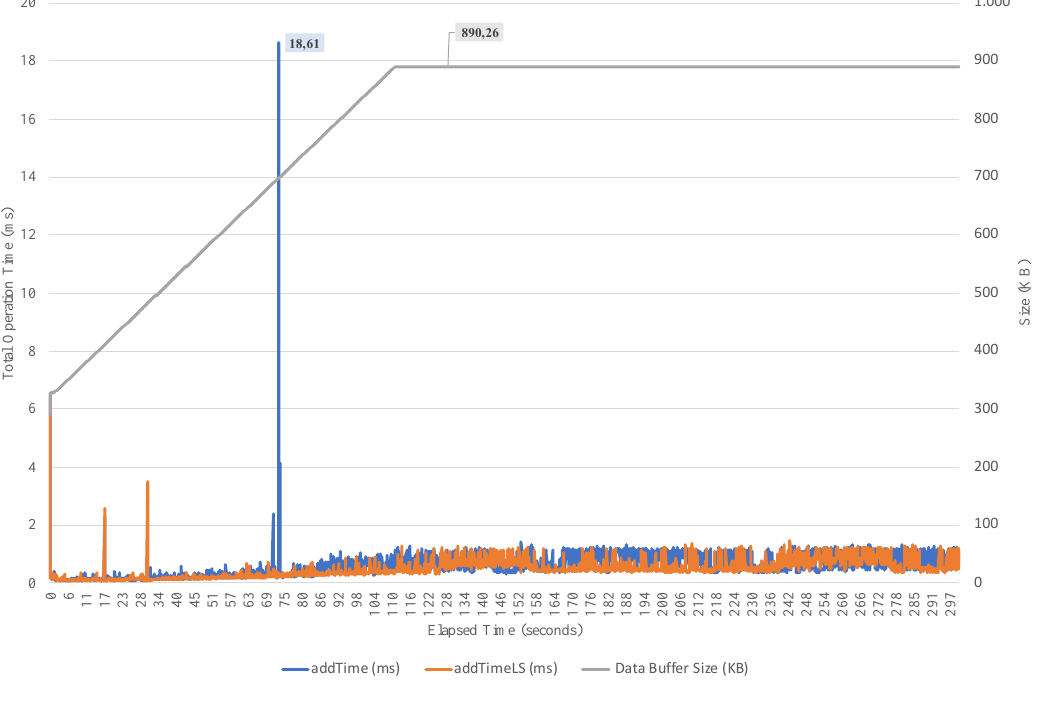
Figure 5. Evolution of the operation time and data buffer size throughout 5 minutes (Simulations 1 and